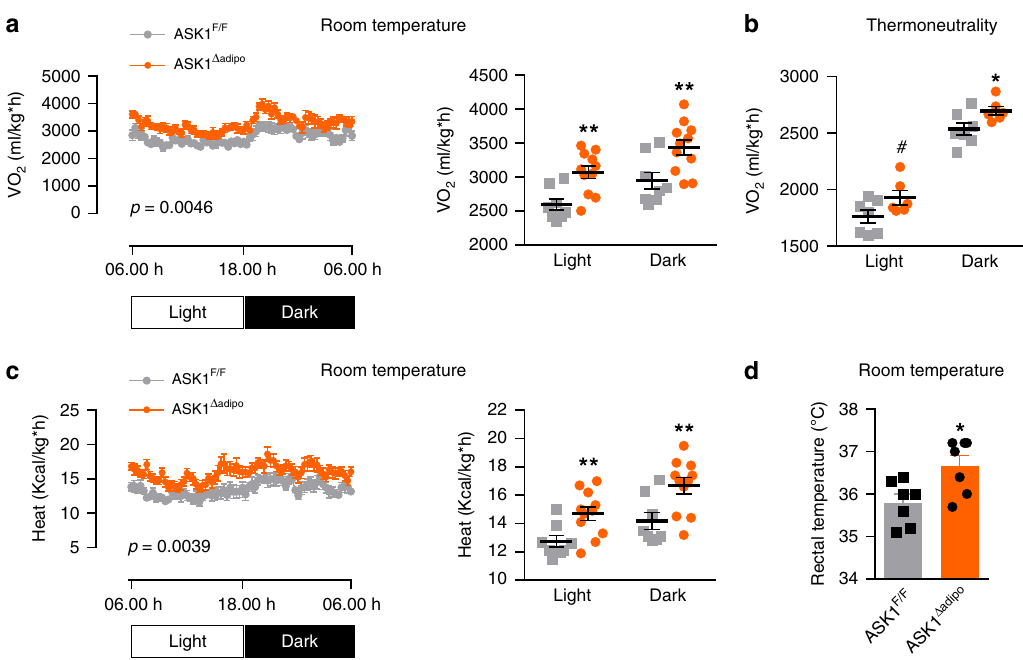
Fig. 3 Increased heat production in HFD-fed ASK1 Δ adipo mice. a Light (day) and dark (night) oxygen consumption in HFD-fed ASK1 F/F ( n = 8) and ASK1 Δ adipo ( n = 11) mice during a 24-h period at RT. ** p = 0.020 (light), ** p = 0.010 (dark). b Light (day) and dark (night) oxygen consumption in HFD-fed ASK1 F/F ( n = 7) and ASK1 Δ adipo ( n = 6) mice during a 24-h period after 20 days housing at thermoneutrality. # p = 0.073, * p = 0.042. c Light (day) and dark (night) heat production in HFD-fed ASK1 F/F ( n = 8) and ASK1 Δ adipo ( n = 11) mice during a 24-h period at RT. ** p = 0.009. d Rectal temperature measured in HFD-fed ASK1 F/F ( n = 7) and ASK1 Δ adipo ( n = 7) mice. * p = 0.015. Values are expressed as mean ± SEM. Statistical tests used: two-sided t -tests for ( a – d ). Source data are provided as a Source Data fi